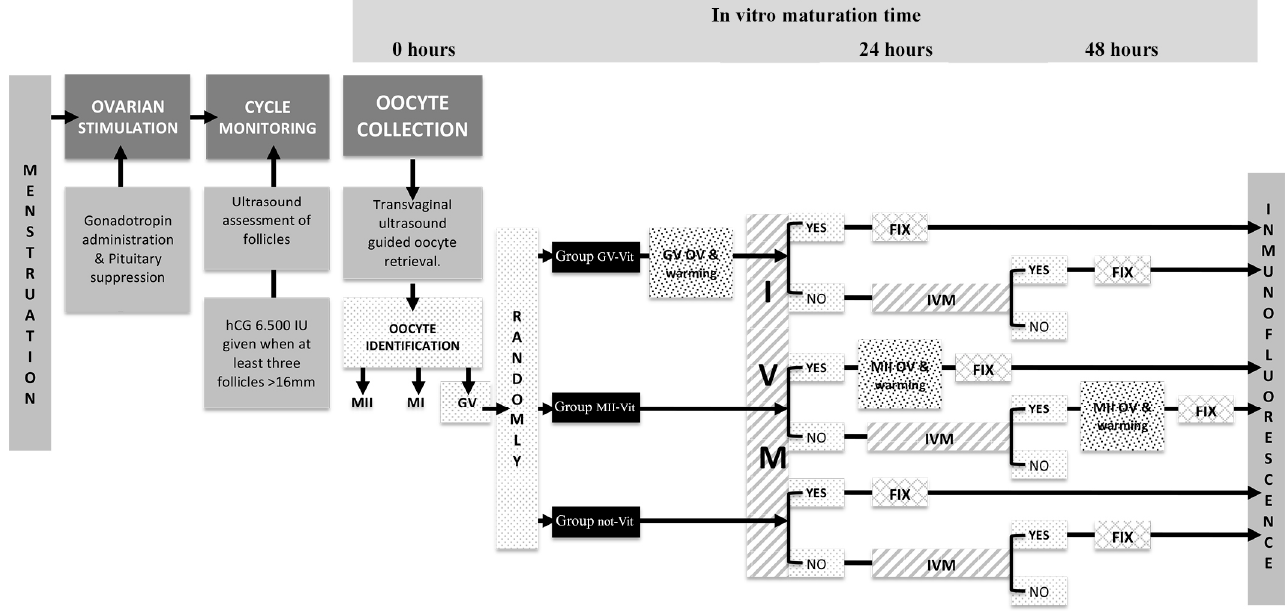
Figure 1. Experimental design that describes in detail the different study groups and the methodology used at the different in vitro maturation times (24 and 48 h). GV, prophase I; MI, metaphase I; MII, metaphase II, OV, oocytes vitrification; IVM, in vitro maturation; FIX, fixation; Vit, vitrification.